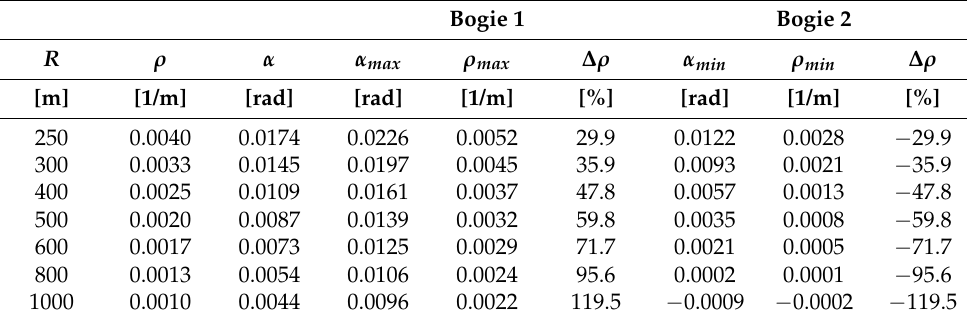
Table 3. Track curvature estimation error for extreme positions of wheelsets.